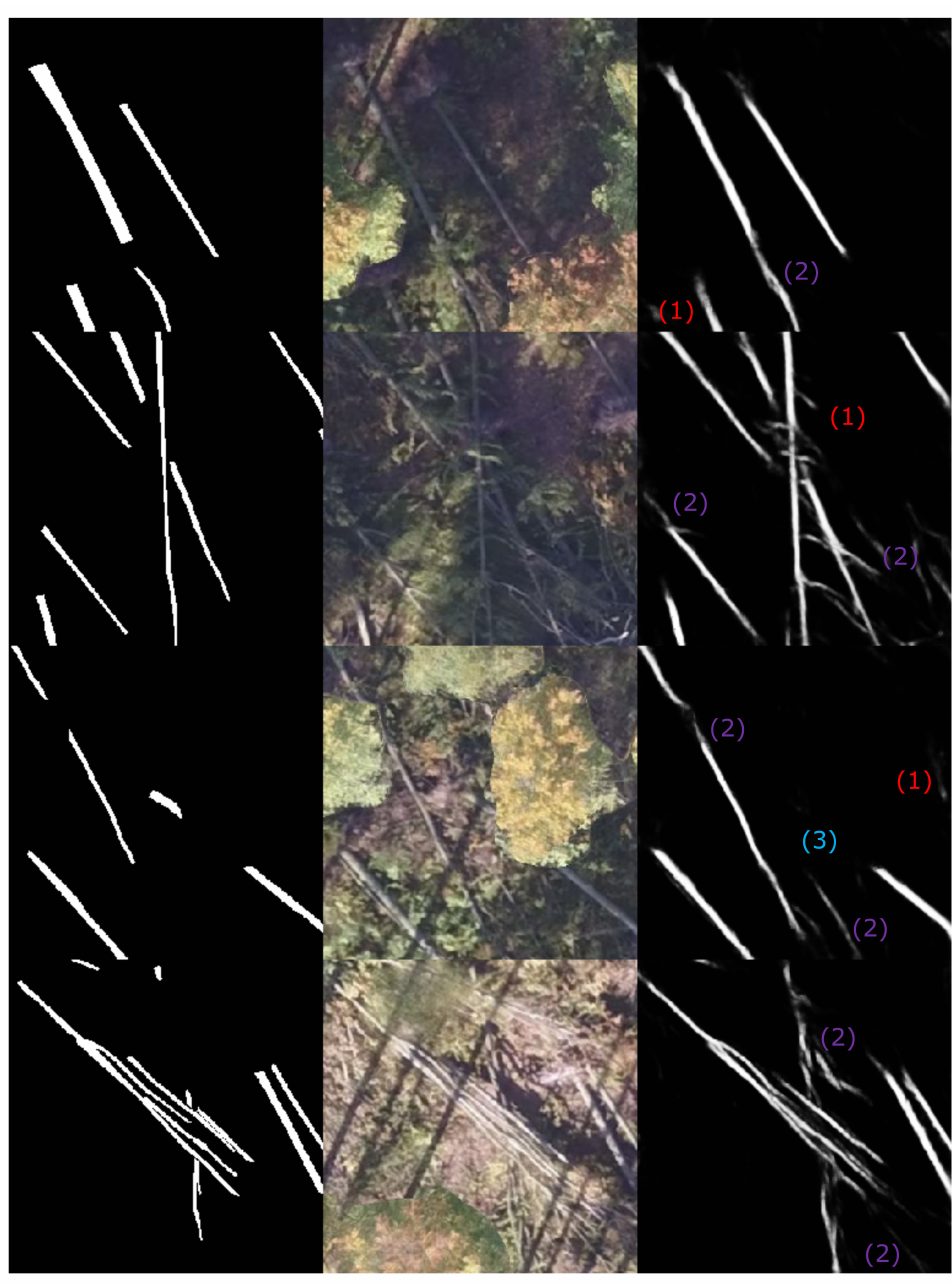
Figure 10. S2Mod100 predicted samples of the test dataset; ( left ): tree mask; middle: test samples; ( right ): predicted result. The result was very similar to the S2Mod50 dataset. A further improvement of the classification was visually hardly detectable. There were less misclassified pixels (1). For all models, one short part of a trunk that is partially covered by shadows was not detected